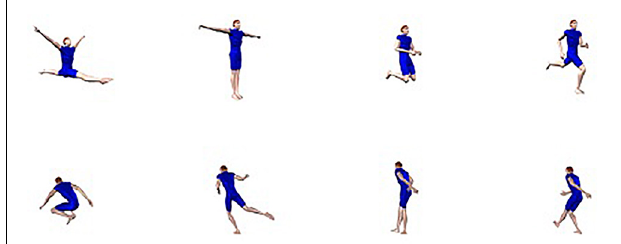
FIGURE 7 | Examples of postures with the trunk in a 45 ◦ (first row) or 225 ◦ (second row) depth orientation. Note that the orientation of the trunk more or less remains the same in each row.